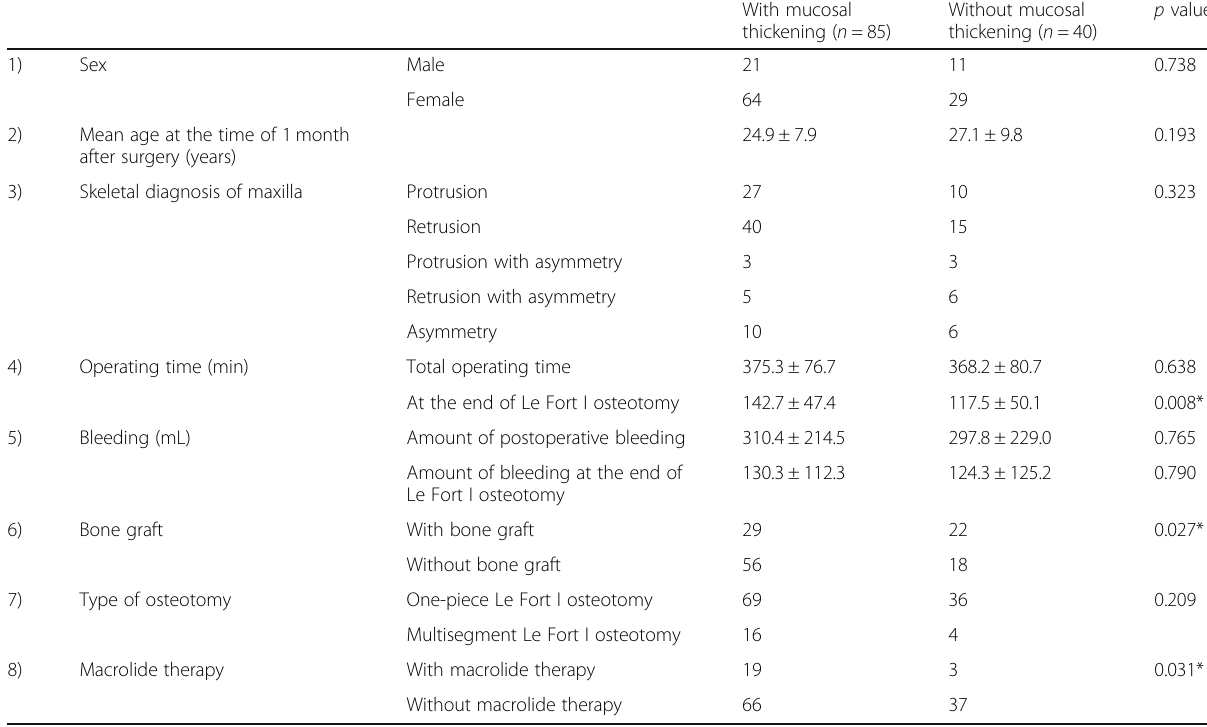
Table 4 Details of the evaluation of factors affecting mucosal thickening and the analysis results at 1 month after surgery